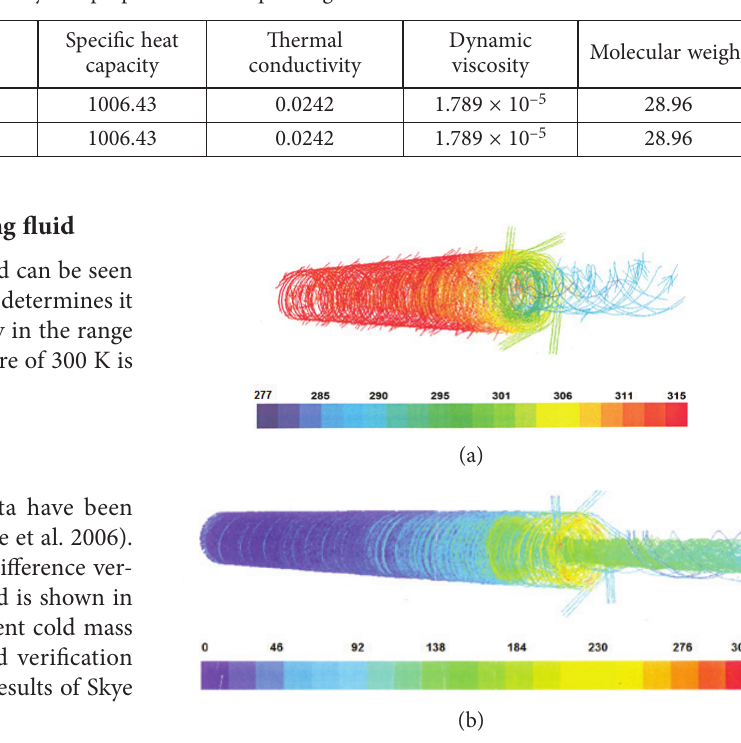
Table 3. Physical properties of the operating